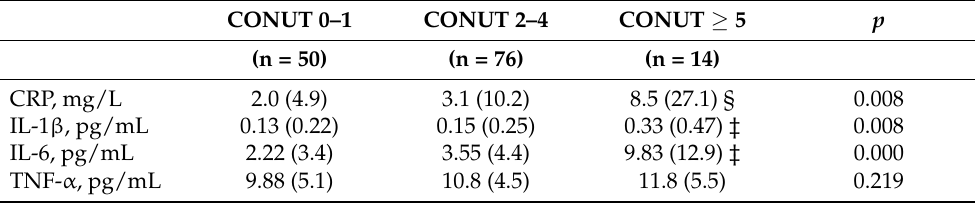
Table 3. Comparisons of CRP and cytokines in CD patients according to CONUT